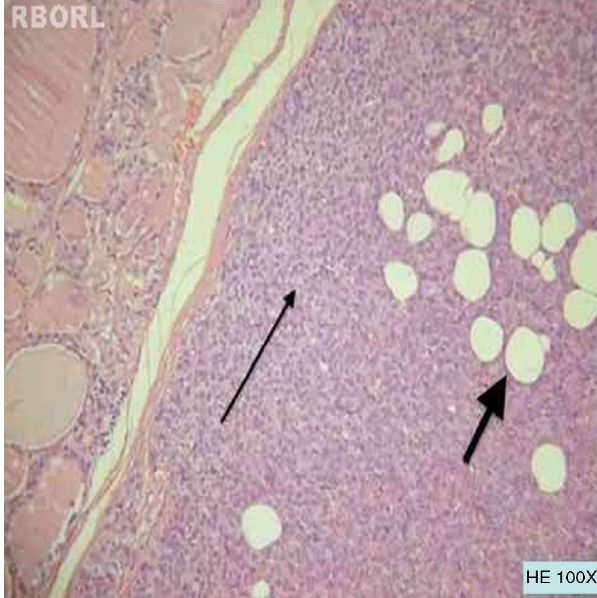
Figure 1 Lipoadenoma in thyroid gland encapsulated nodule. HE 100 × , Thick shorter arrow, adipocyte accumulation; thin longer arrow, benign follicular